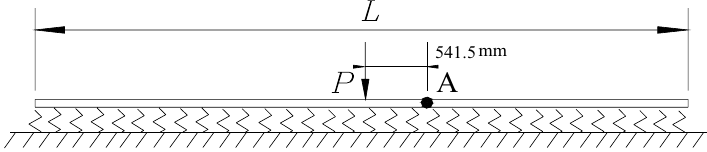
Fig. 8. A uniform Bernoulli-Euler beam with free end resting on Winkler foundation under a concentrated static load. 18.05 m, and k w (stiffness coefficient of Winkler foundation) = 4.0 × 10 6 N/m 2 . These parameters of this